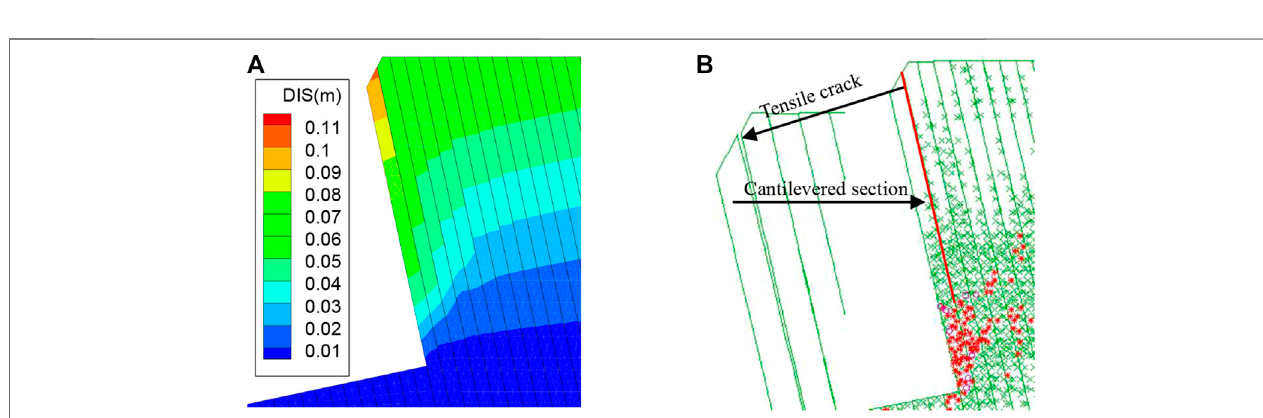
FIGURE 6 | Displacement and plastic zone distribution of the upper rock layers after the formation of the FOIP. (A) : Displacement distribution; (B) Plastic zone distribution.